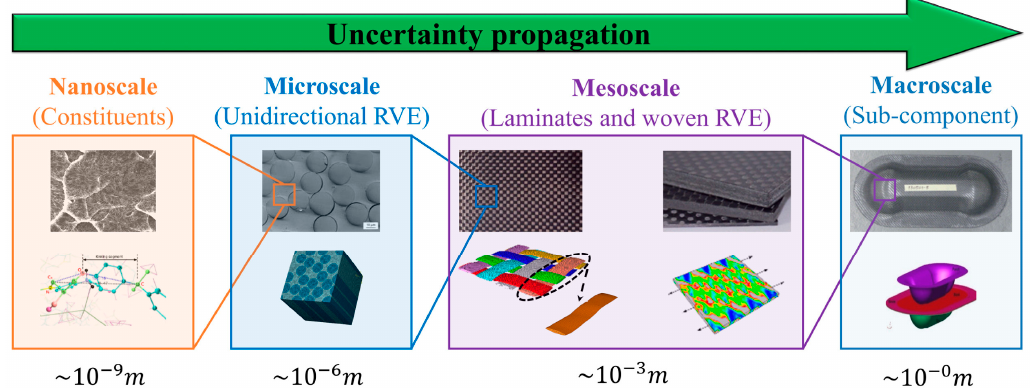
Figure 4. Schematic view of a four-scale woven fiber composite with polymer matrix: In computational modeling of this structure, each integration point at any scale is a realization of a structure at a finer scale. Due to the delicacy of materials at fine-scales, RVEs at lower scales may embody more uncertainty than those at higher scales. To quantify the uncertainty in a macroscopic quantity of interest, the relevant uncertainty sources at the lower scales should be identified for uncertainty propagation. Reproduced with permission [41].